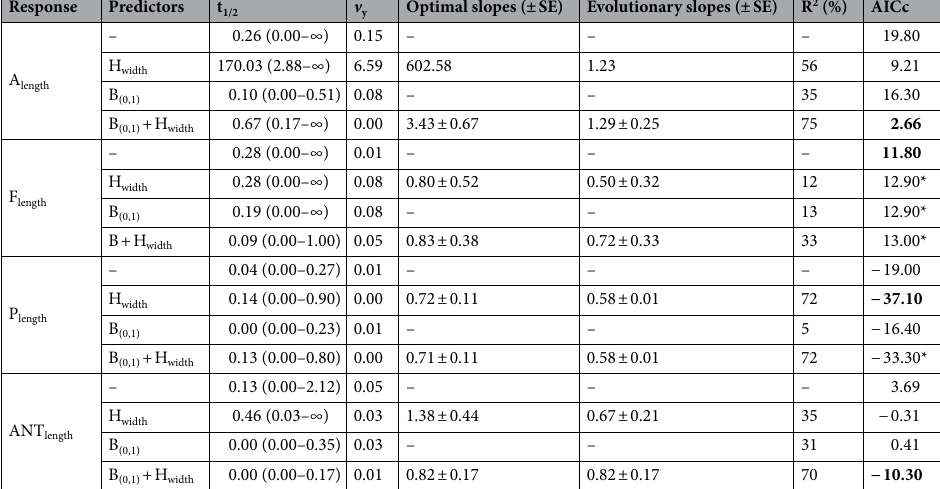
Table 4. Phylogenetic comparative analyses of the evolution of antennal size in the satellite and the non- satellite species. For each model, we show the maximum-likelihood estimates of phylogenetic half-life, t 1/2 , in units of tree length (total tree length = 1) with its 2LogL support region, the stationary variance, v y , GLS estimates of the slope of the optimal and evolutionary regressions with standard errors (SE). Phylogenetically corrected R 2 , in percentage, represents model fit. The best model from four tested for each response variable is chosen based on the best corrected Akaike Information Criterion (AICc) score and is given in bold. Models with Δ < 4 where Δ measures the information loss (or distance) of each model (AICc i ) in comparison with the best one having the lowest AICc value (AICc min ) according to equation Δ i = AICc i – AICc min , are considered equally supported and are denoted by asterisk. When a “–” is entered for the predictor variable, only an intercept is included in the model. In this cases, the phylogenetic half-life is a measure of the overall phylogenetic effect on the response variable. H = head, F = funiculus, P = pedicel, A = arista, ANT = antenna, B (0,1) = binary trait describing host-finding strategy (SAT vs.